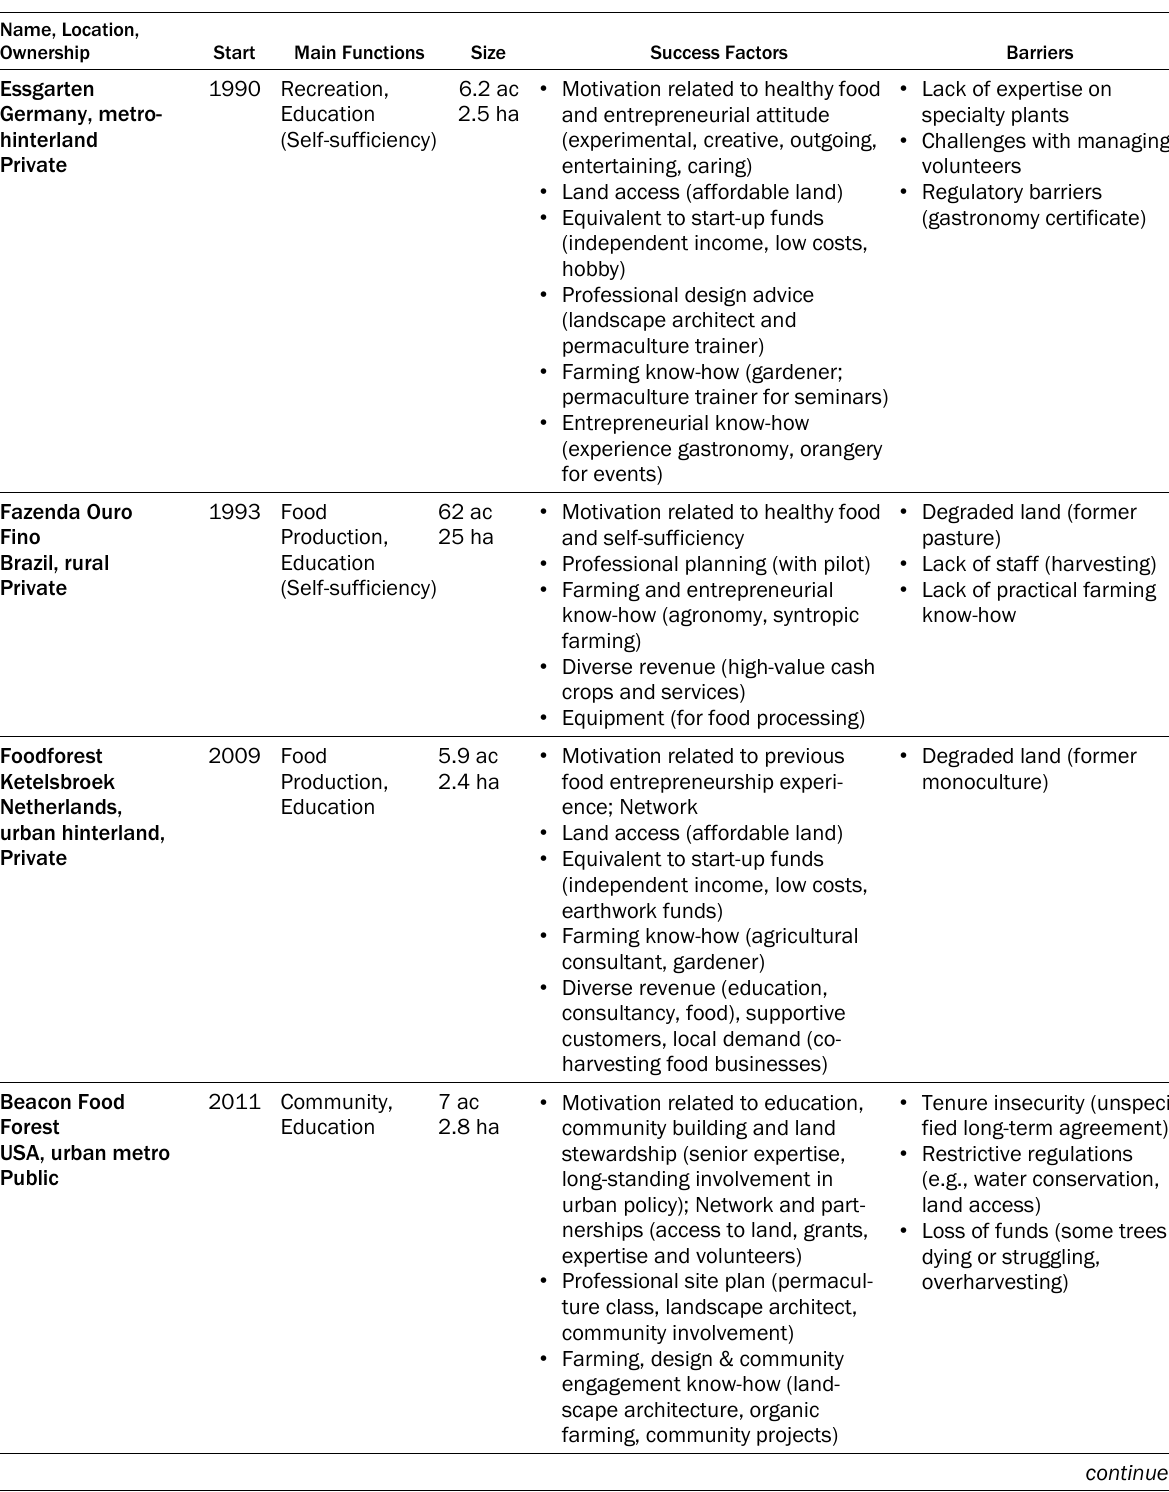
Table 3. Main Success Factors and Barriers of Implementing Food Forests Name, Location,